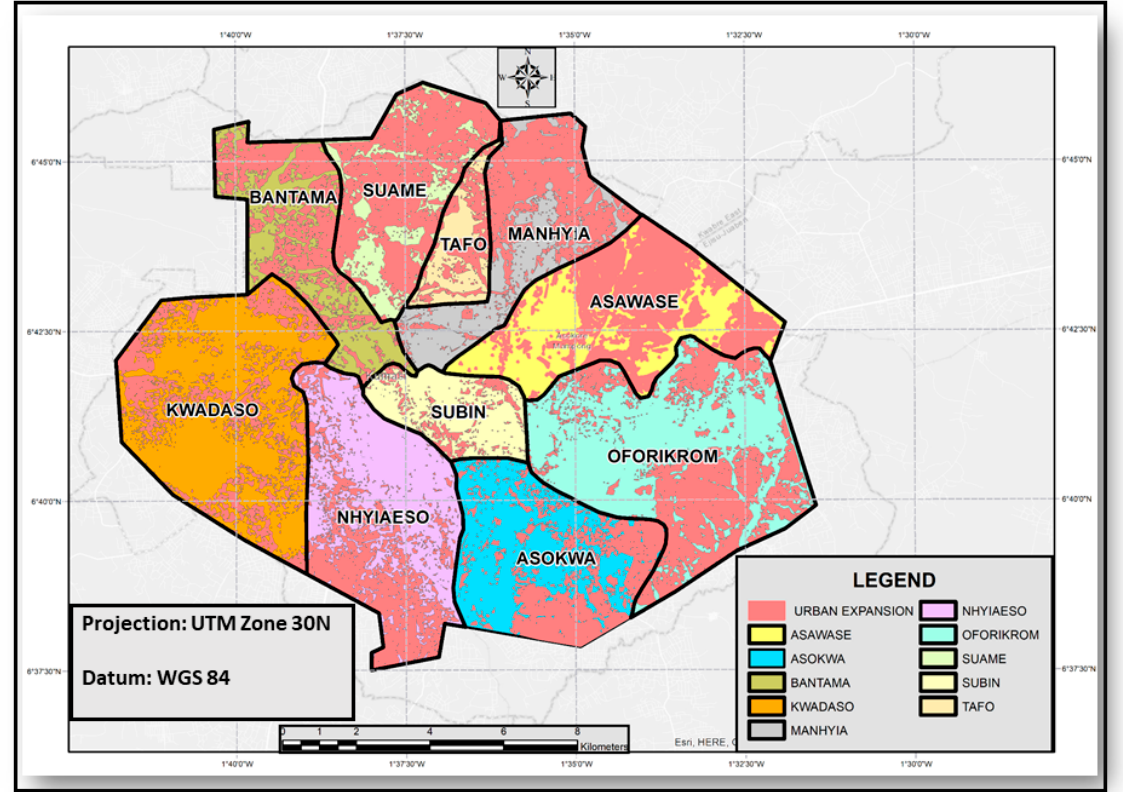
Figure 8. Urban expansion in sub-metropolitan areas.